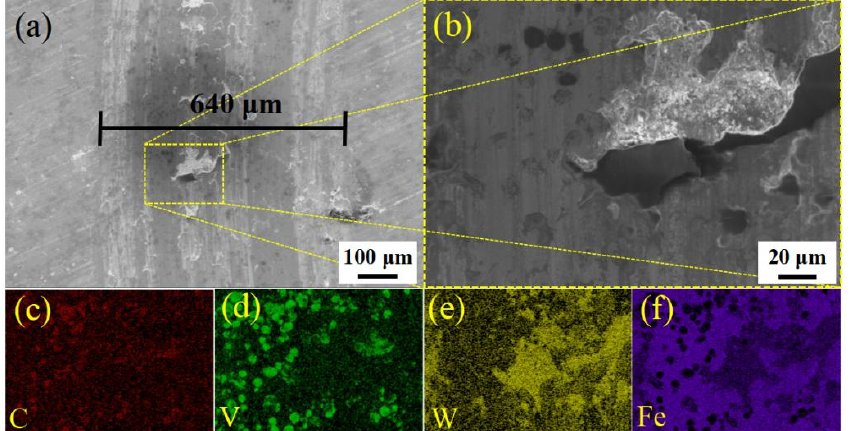
Figure 9. SEM morphologies and the corresponding EDS elemental distribution of wear tracks in the MQPT-treated sample. ( a ) SEM image of wear track; ( b ) Magnified morphology of ( a ) in the yellow box with the dotted line; ( c ) Distribution of C element; ( d ) Distribution of V element; ( e ) Distribution of W element; ( f ) Distribution of Fe